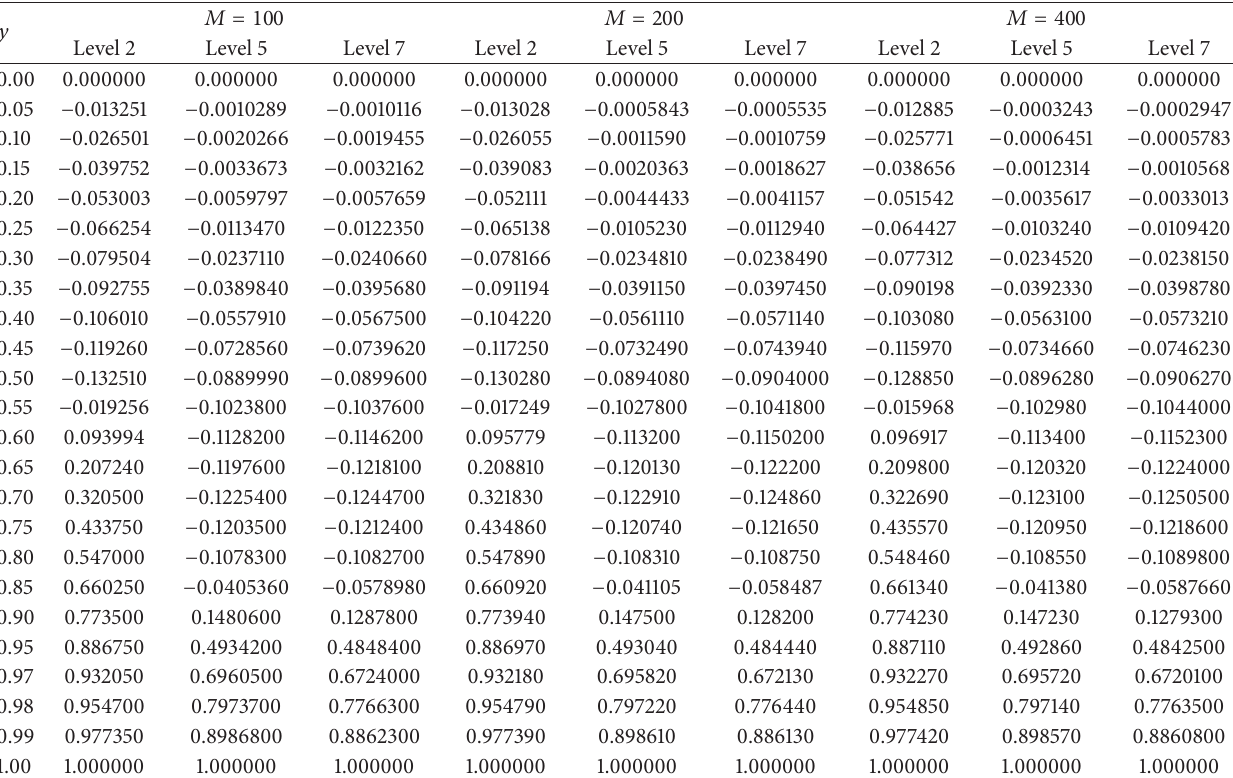
Table 4: Values of the 𝑥 -component of the velocity along the vertical center line for Bn = 10 .